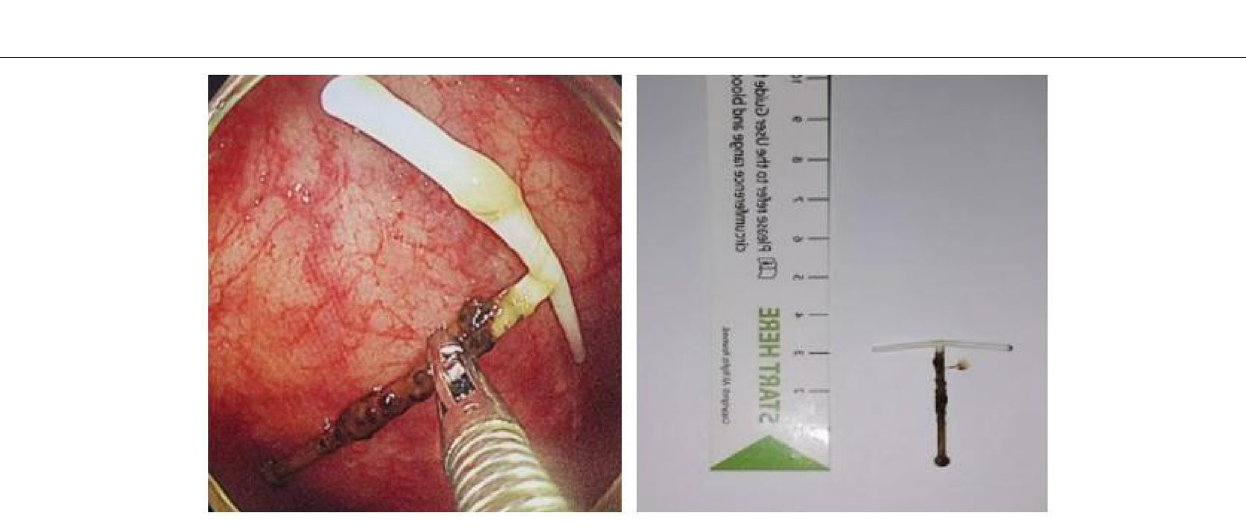
FIGURE 2 | Laparoscopic-endoscopic cooperative surgery and no obvious abnormality were found during hysteroscopy. (A) The IUD was removed under laparoscope. (B) The IUD embedded in the colon wall showed a white protuberance outside the cavity (arrow). (C) Haemoclips at the wound site to prevent perforation of the colon. (D) The weak intestinal wall was sutured to prevent perforation. (E) Localized erosion at the posterior wall of the uterus and dense adhesions between the uterus and colon. (F) Bipolar coagulation to stop bleeding. (G) Morphology of uterine cavity. (H) Opening of right fallopian tube. (I) Opening of left fallopian tube.